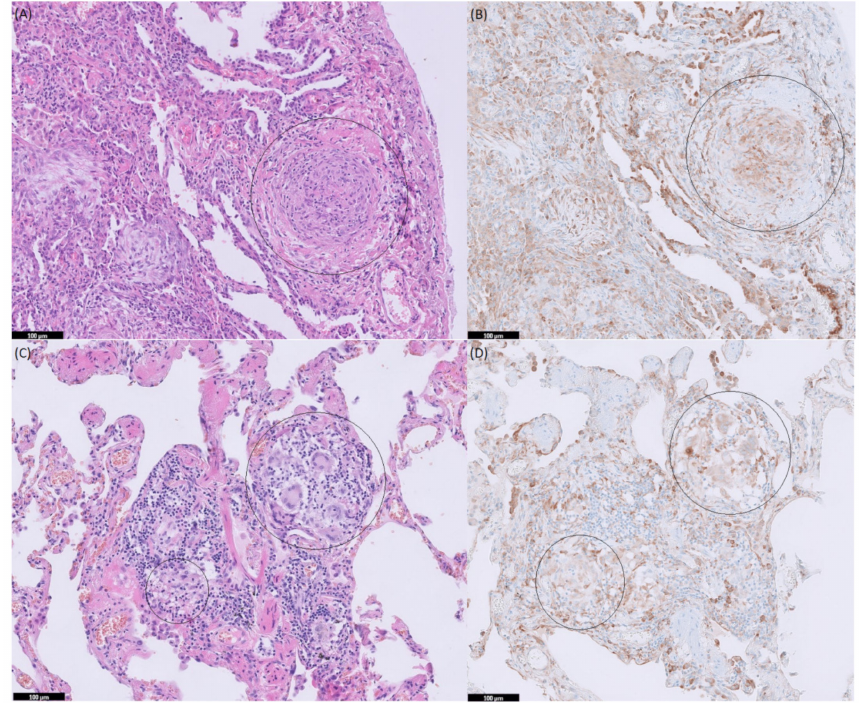
Figure 3. Immunohistochemistry (IHC) staining in lung tissue of patient with granulomatosis with polyangiitis (GPA); ( A ) Hematoxylin-eosin (HE) staining and ( B ) p-S6 (mTORC1 activity) staining, and in lung tissue of patient with hypersen- sitivity pneumonitis (HP); ( C ) HE staining and ( D ) p-S6 (S6K activity) staining. Circled area represents